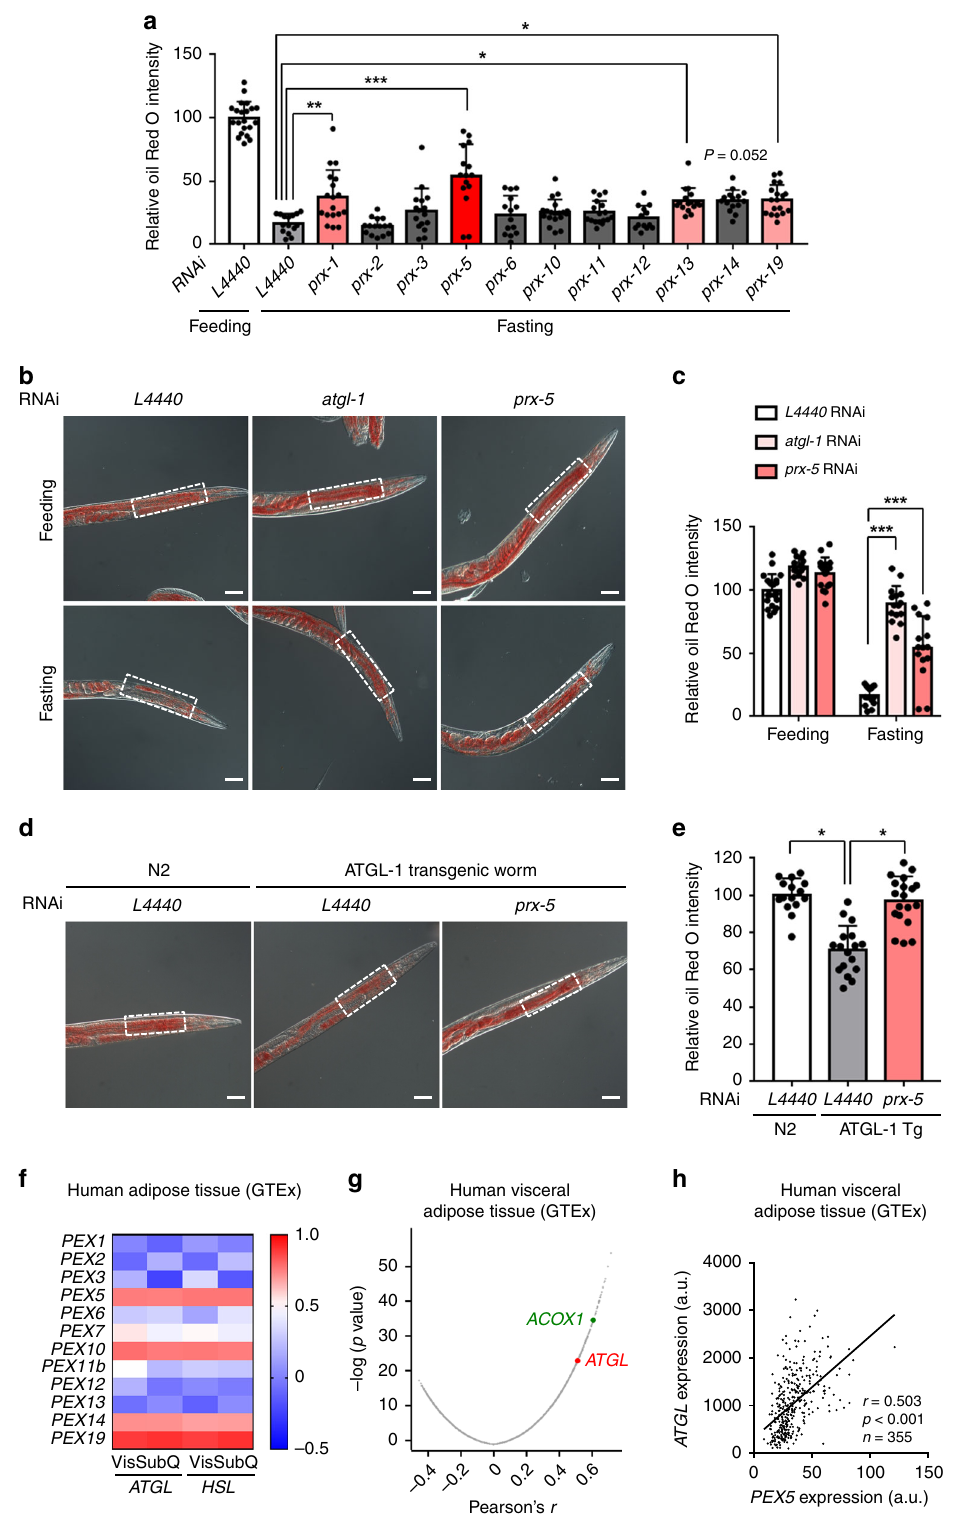
CGI-58-suppressed adipocytes. As shown in Supplementary Fig. 6c, CGI-58 suppression did not affect ATGL translocation onto LDs upon ISO. These data imply that PEX5 and